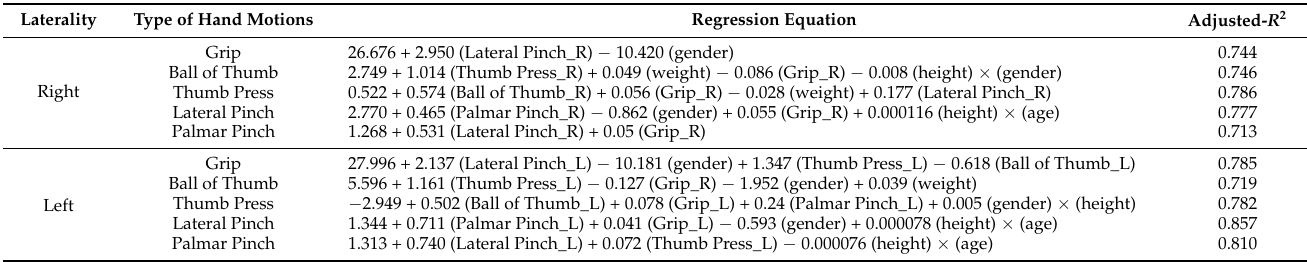
Table 4. The best prediction models using different types of hand exertion, demographic variables, and their interaction by laterality.